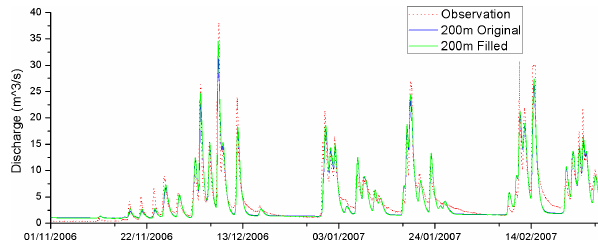
Fig. 12. Whole catchment flow simulations using 50m resolution DEM in MIKE SHE.